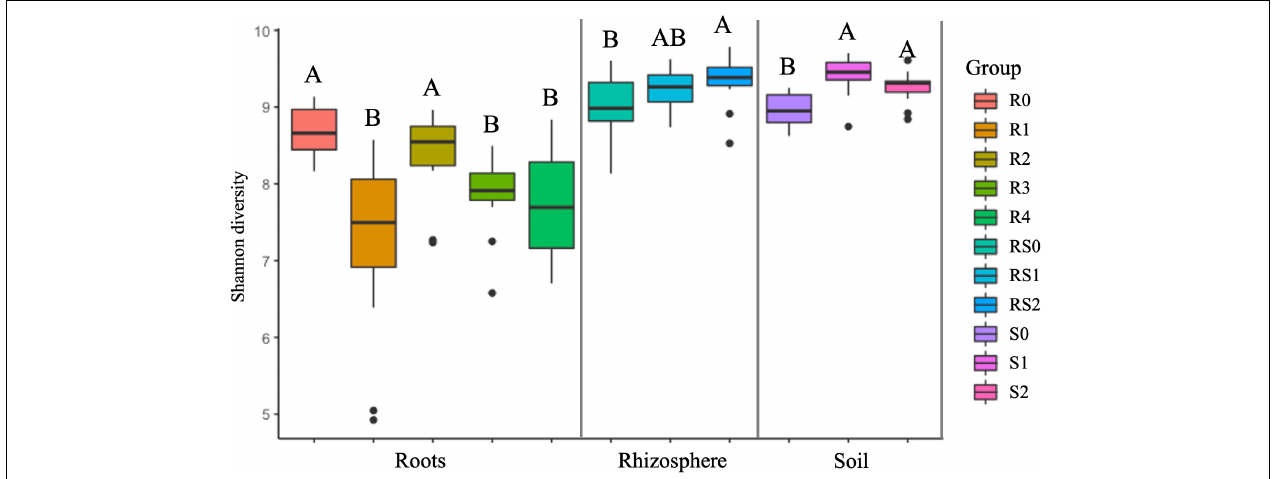
FIGURE 2 | Estimated shannon diversity. For each variable, data followed by different letters are significantly different according to the Kruskal–Wallis pairwise test ( p < 0.05).